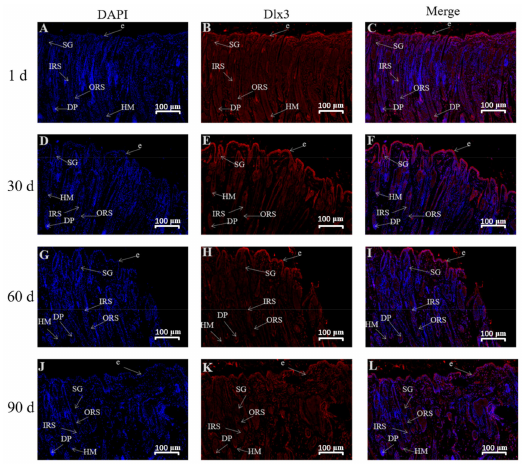
Figure 7. Immunofluorescence staining for Dlx3 in skin tissues of Gansu Alpine Merino at various ages (10 × ). ( A , D , G , J ) The blue-colored tissue shows the DAPI-labeled nuclear fluorescent color- ing; ( B , E , H , K ) the red tissue shows the fluorescent coloring of Dlx3; ( C , F , I , L ) Fluorescent coloring after merging Dlx3 with DAPI. ORS: outer root sheath; IRS: inner root sheath; DP: dermal papilla; HM: hair matrix; e: epidermis; SG: sebaceous